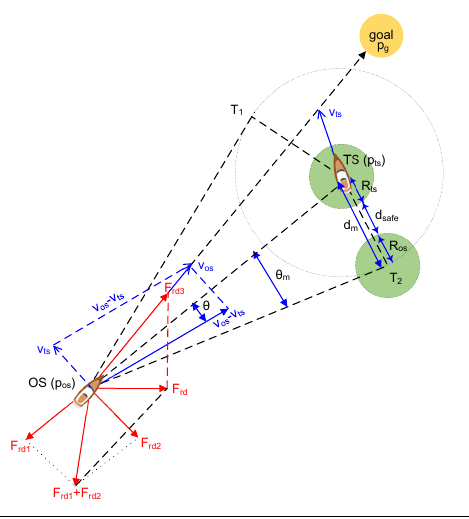
Figure 3. Modified APF for a dynamic TS